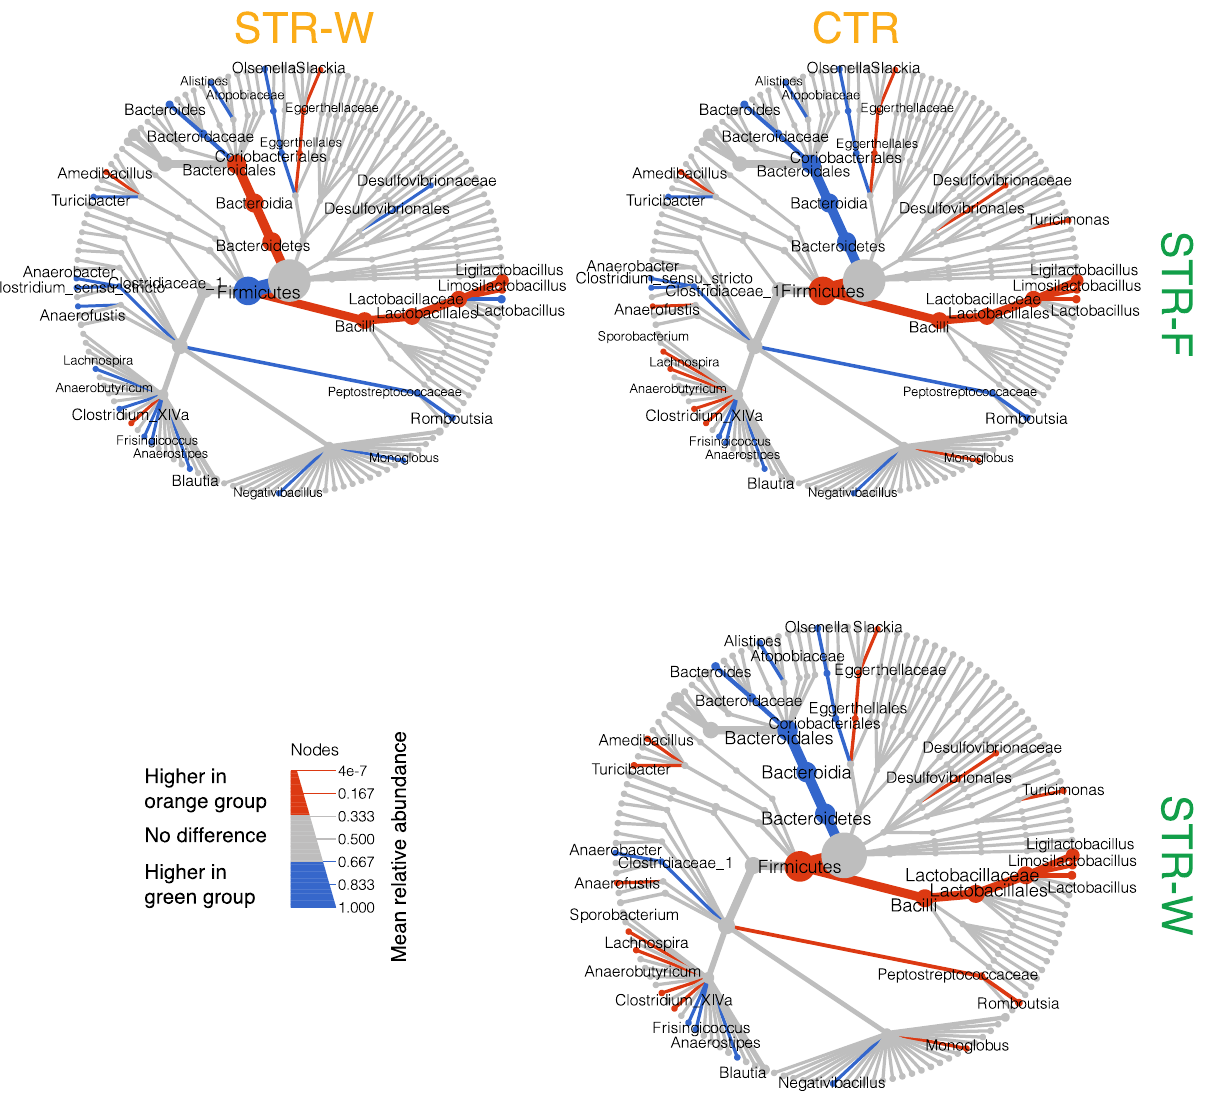
Figure 6. Tree plot showing the comparison of relative taxon abundances between groups. The largest node in the center is the kingdom bacteria. Along the tree branch outward, the next node is the phylum level, then followed by Class, Order, Family, and Genus. The size of the node is proportional to the mean relative abundance in the corresponding phylogenetic level. A node is labelled and colored when it has significantly different relative abundances (permutation test) between groups. Figure was made in R as described in the “Methods”